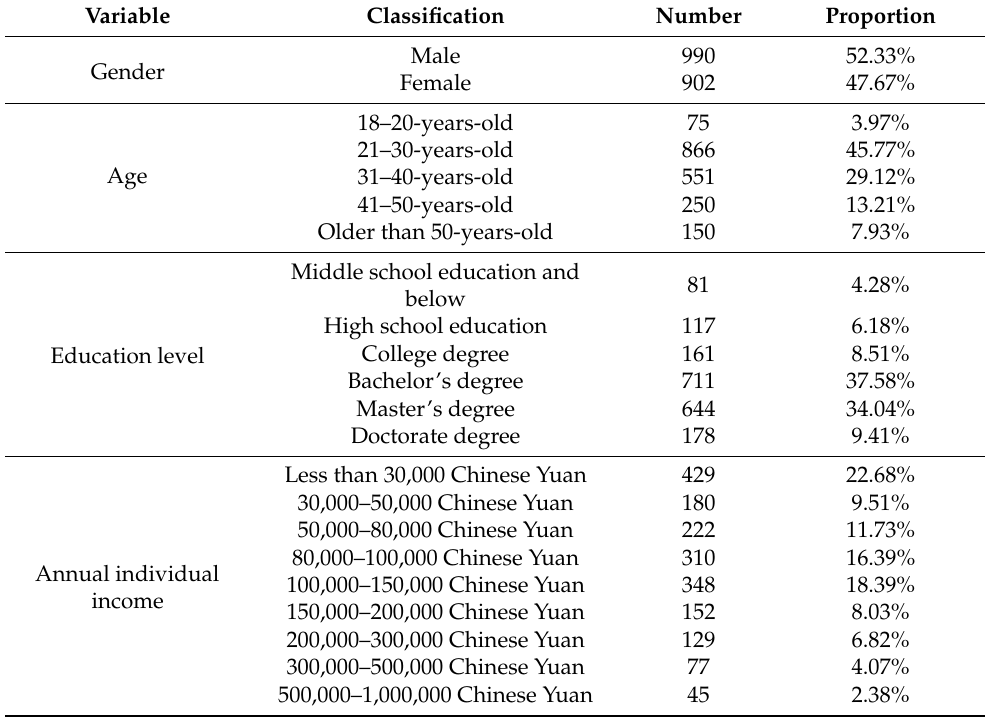
Table 4. The demographic distribution of the 1892